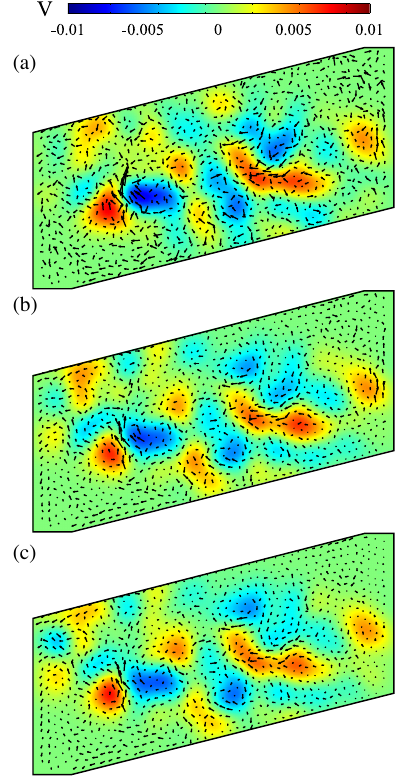
Figure 2. Coarse grained plots of vorticity at shear strain γ = 0 . 0972 with packing fraction φ = 0 . 796 calculated from di ff er- ent step size: (a) ∆ = 2, (b) ∆ = 6, and (c) ∆ = 10. Black arrows correspond to particle displacements (rescaled for better visualization but with the same scale for